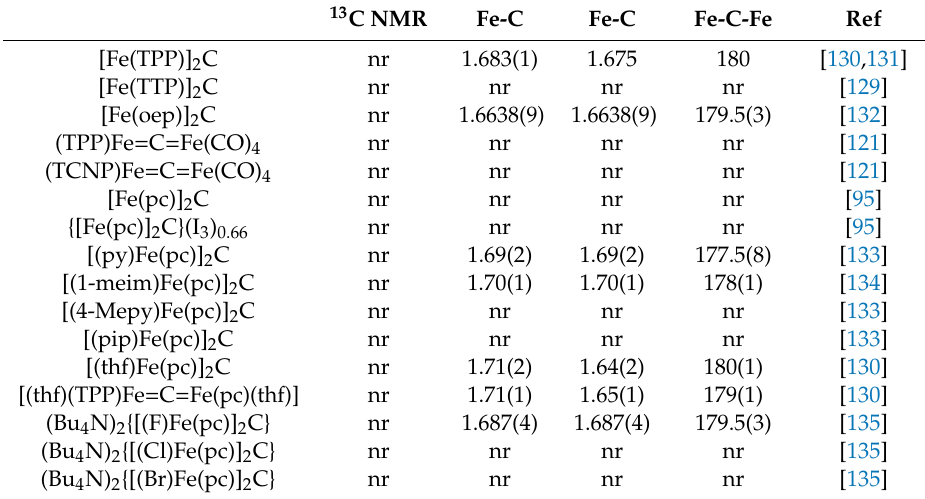
Table 18. Fe-C distances (in Å) and Fe-C-Fe angles (in deg). 13 C NMR of the bridging carbon atom in